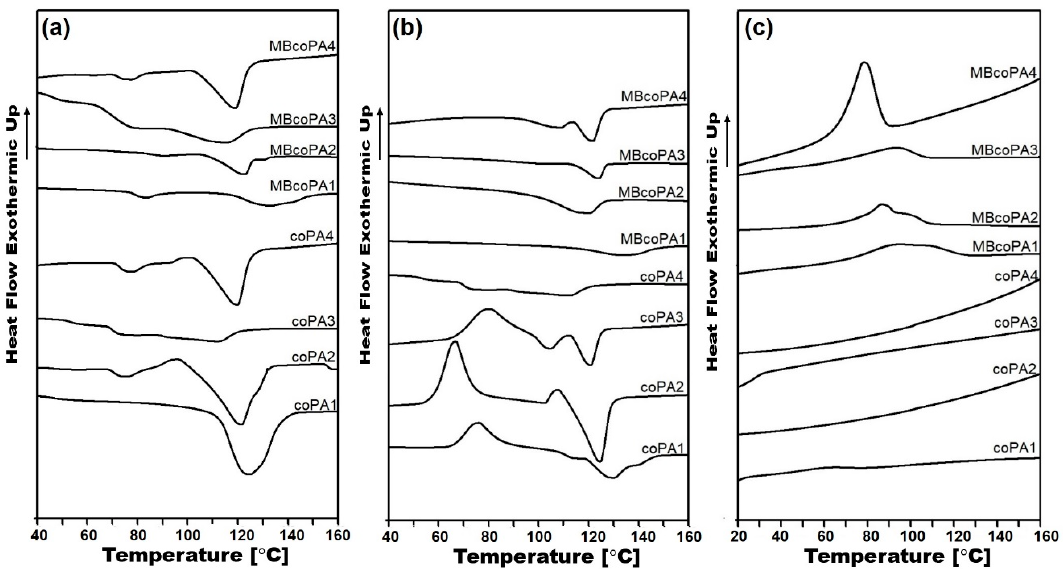
Figure 6. ( a ) First heating curves; ( b ) second heating curves; and ( c ) cooling curves for the unfilled coPAs and their masterbatches containing 7 wt % MWCNT.